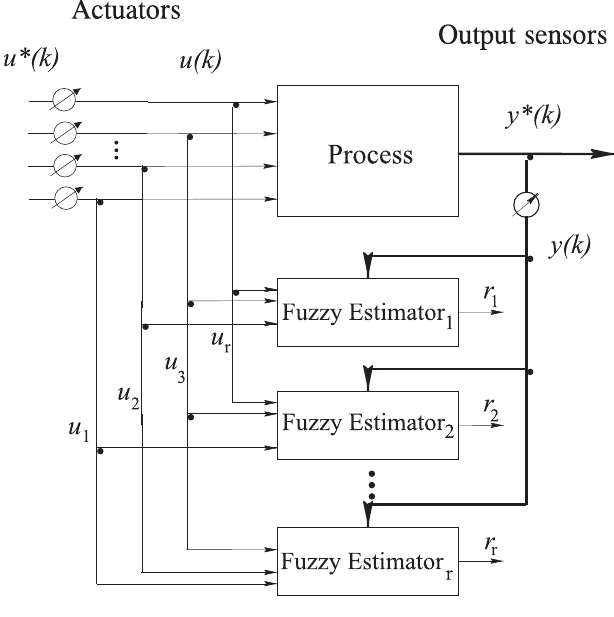
Figure 4. Fuzzy estimator scheme for actuator fault